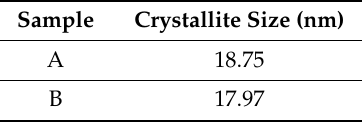
Table 2. Crystallite sizes of the AgNPs obtained using the Scherrer equation.